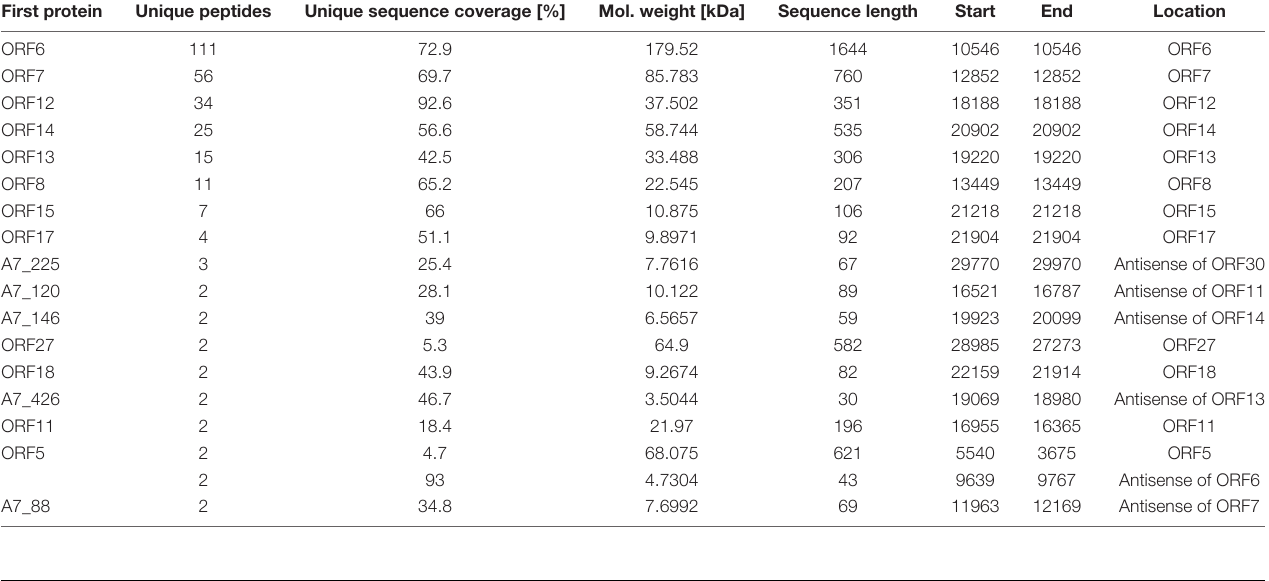
TABLE 3 | Phage vB_ShiP-A7 particle proteins identified in mass spectrometry.